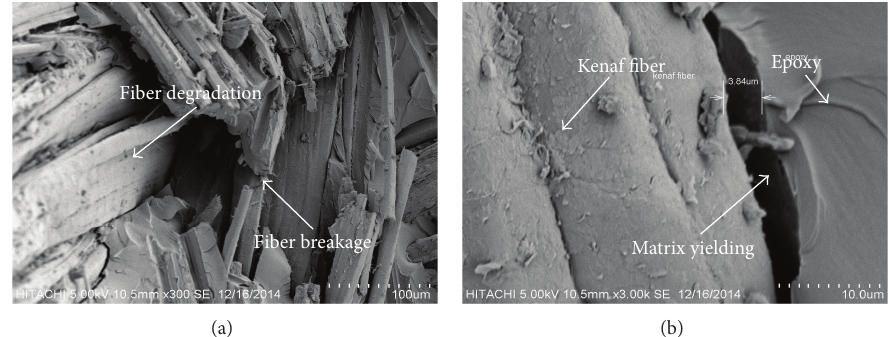
Figure 9: (a) The SEM micrographs of the tensile failure surfaces of KFRE. (b) The strong bonding of the kenaf fibre and the epoxy matrix.